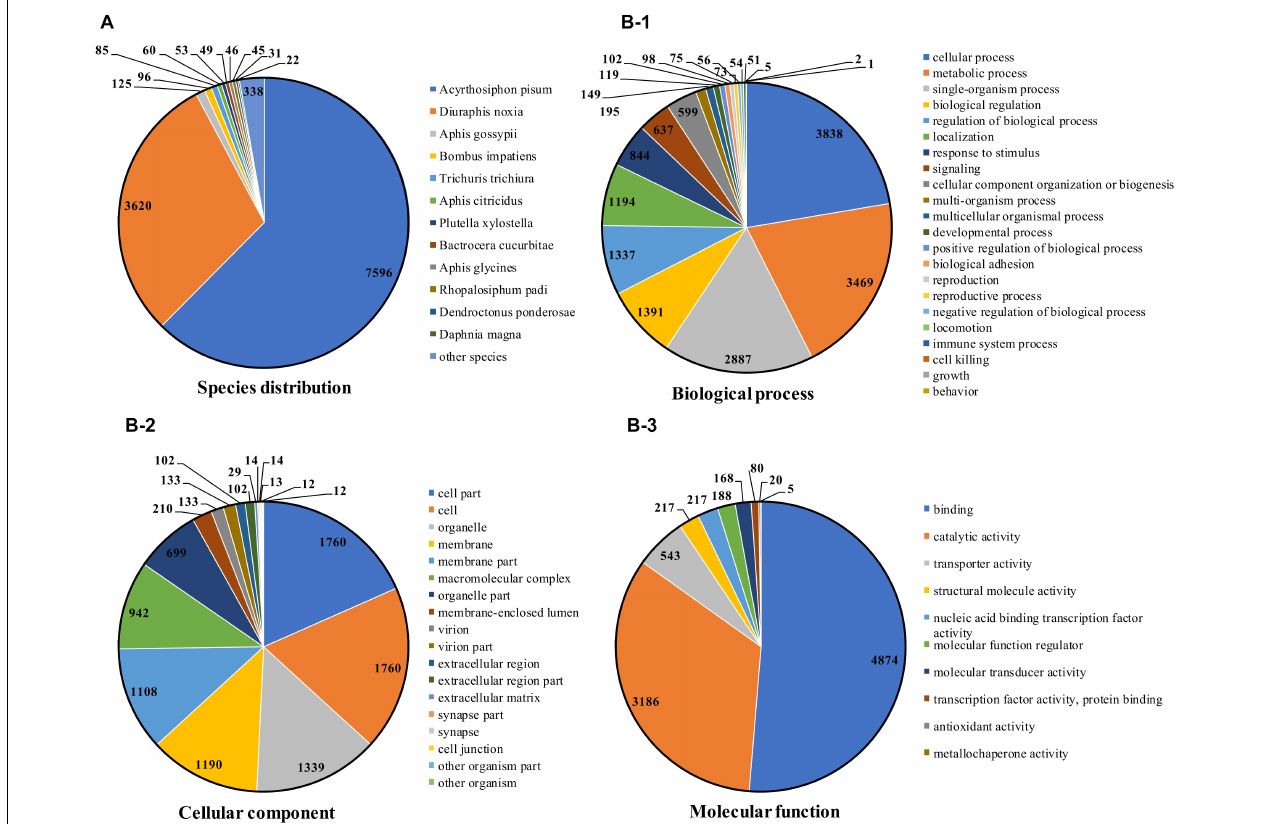
FIGURE 1 | Species distribution annotated from the NCBI NR database (A) , and functional annotation using the GO database (B) .